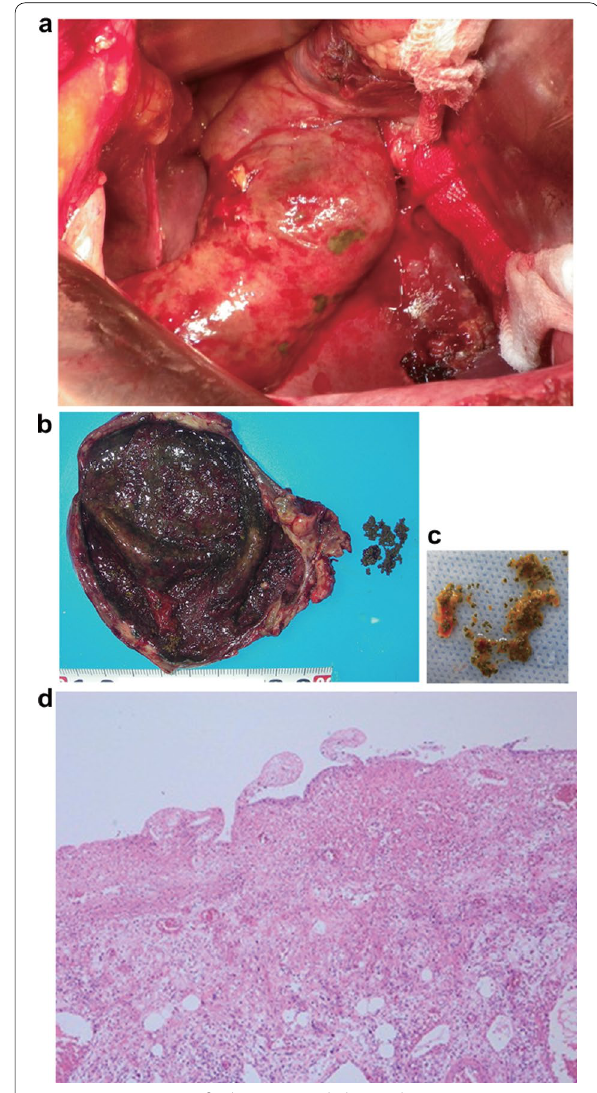
Fig. 3 Intraoperative findings. Intra-abdominal view ( a ). Macroscopic findings show a distended gallbladder with a dark-red surface ( b ). Also, the gallbladder shows a thickened wall and necrotic mucosa with many sand granular stones inside ( b , c ). Microscopic findings include necrosis, edema, and moderate infiltration of inflammatory cells, including neutrophils and eosinophils ( d